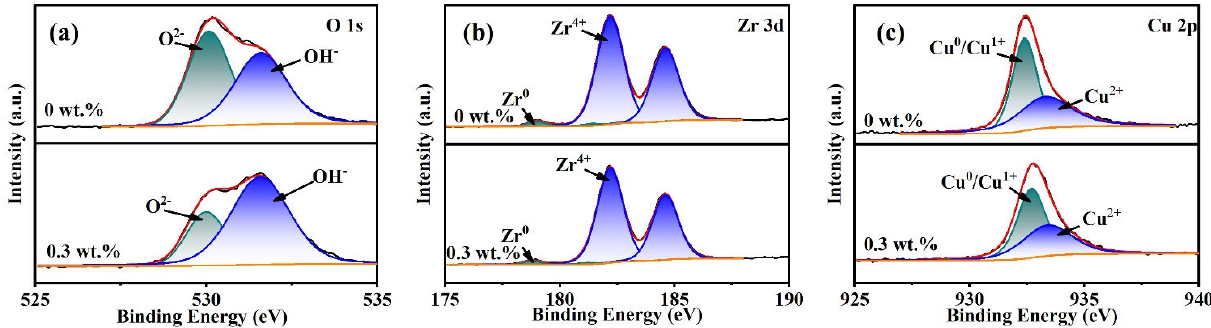
Figure 10. XPS narrow spectra of polished sample surfaces with H 2 O 2 concentration of 0 wt.% and 0.3 wt.%. ( a ) O1s; ( b ) Zr 3d; ( c ) Cu